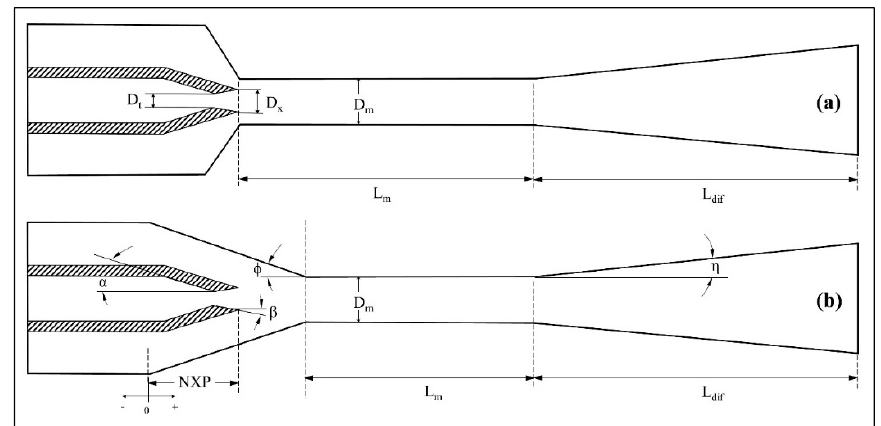
Figure 3. Ejector geometries: ( a ) constant area mixing ejector and ( b ) constant pressure mixing ejector.